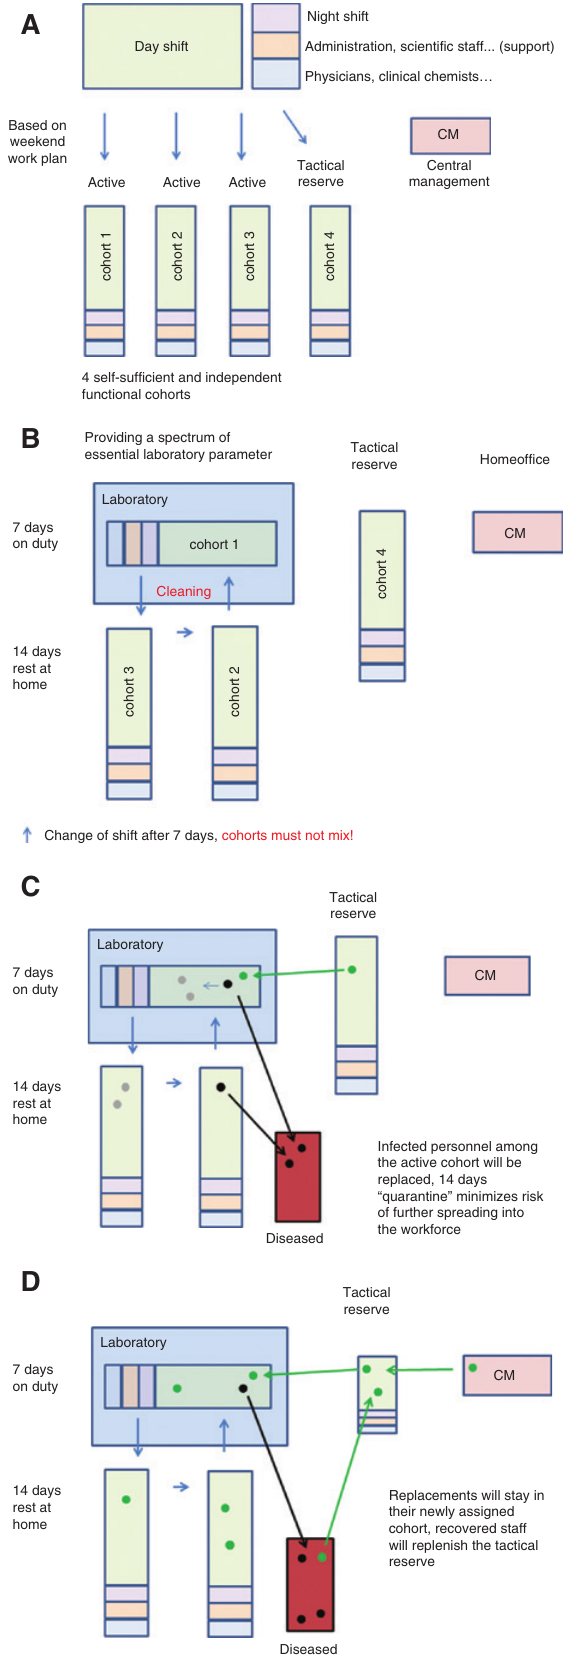
Figure 1: Schematic drawing of a cohort-based emergency plan to maintain essential laboratory functionality during the 2020 COVID-19 epidemic. (A) Divide workforce into four self-sufficient independent cohorts. (B) Three cohorts are active, one builds a tactical reserve.